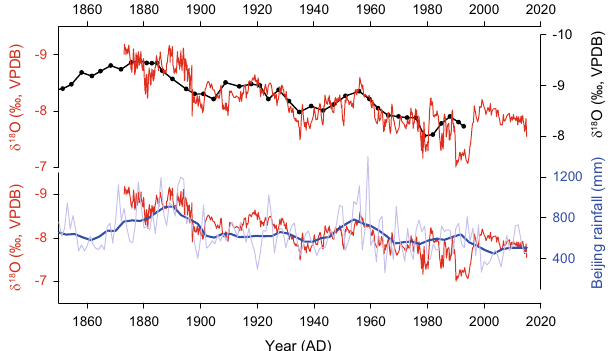
Figure 2. Comparison between the Shihua record with other records from Beijing. ( a ) Comparison between the Shihua XMG-1(red) and S312 43 (black dotted line) δ 18 O records. ( b ) Comparison between the Shihua XMG-1 record (red) and annual precipitation record in Beijing (blue) 46 . The thick line is the 5-year running mean